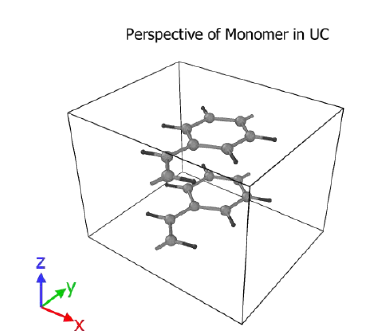
Figure 8. Reference frame and starting orientation of two PPV monomers in the simulation box. Table 4. Initial simulation cell for oligomer crystallizations.